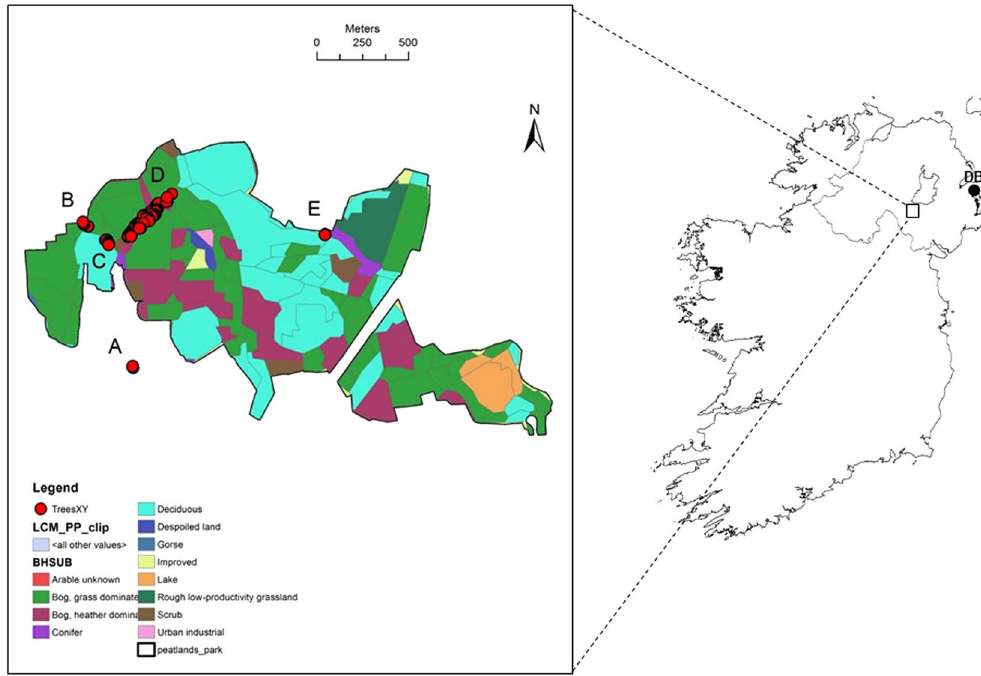
Figure 1. Location of the Peatlands Park population of Frangula alnus in Co. Armagh, Northern Ireland. Zoomed area shows the distribution of F . alnus in Peatlands Park, with the five fragments sampled (labeled A–E), mapped using ArcMap 10. The coloured area indicates a designated Special Area for Conservation (SAC). Land classes were taken from the CEH Land Cover Map (NERC/Centre for Ecology & Hydrology). DB – Drumawhey Bog (extinct population referred to in